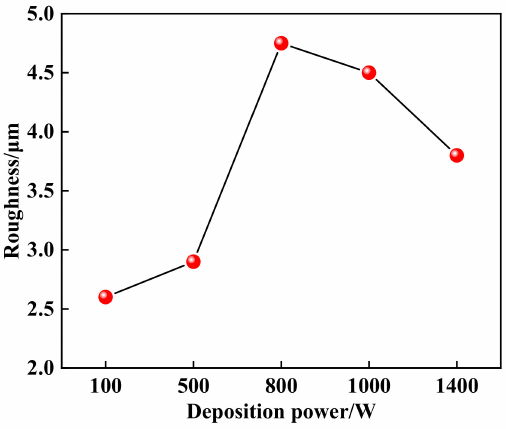
Figure 5. Effect of deposition power on the roughness of